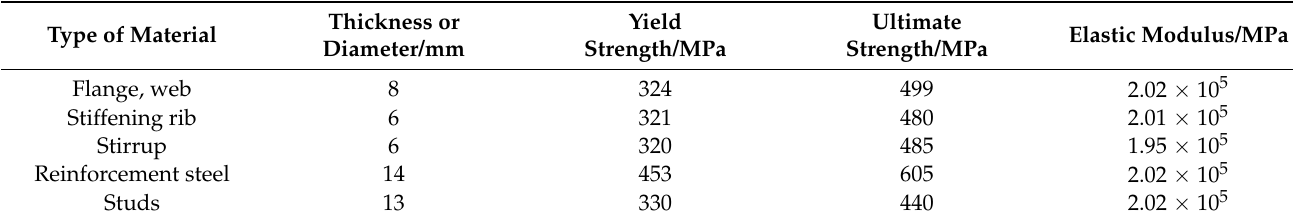
Table 3. Mechanical properties of steel.